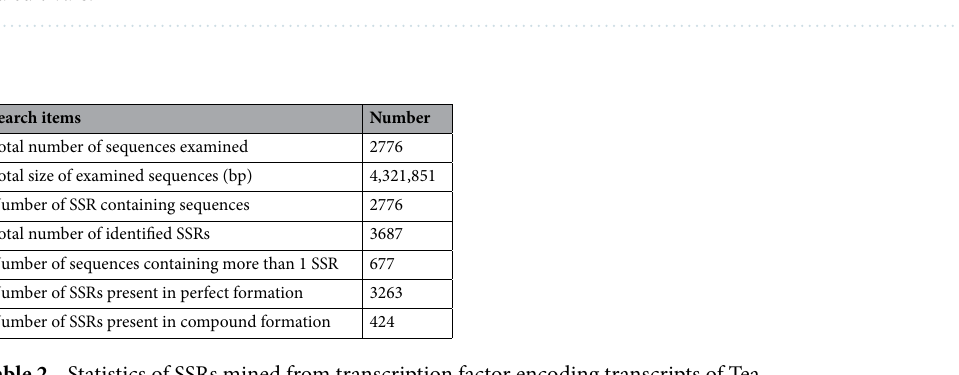
Table 1. Statistics of overall de novo assembled transcripts derived from transcriptome sequencing of twenty tea cultivars.